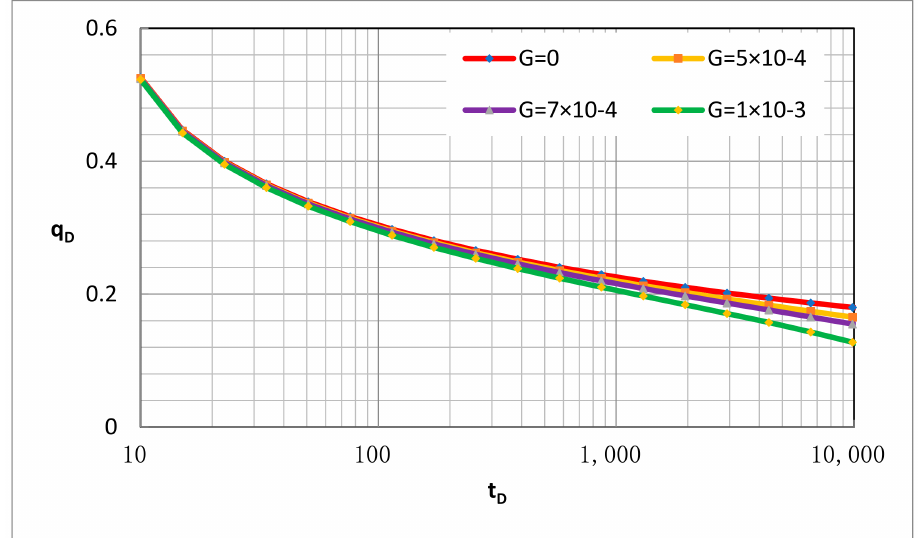
Figure 8. Production decline curve plate of an infinite low-permeability reservoir. For closed outer boundary reservoirs, both dimensionless start-up pressure gradi- ent and outer boundary radius will affect the shape of the production decline curve (Figures 9 and 10). The starting pressure gradient affects the slope of the curve. The larger the dimensionless starting pressure gradient is, the faster the output will decline; the smaller the outer boundary radius is, the faster the output will be